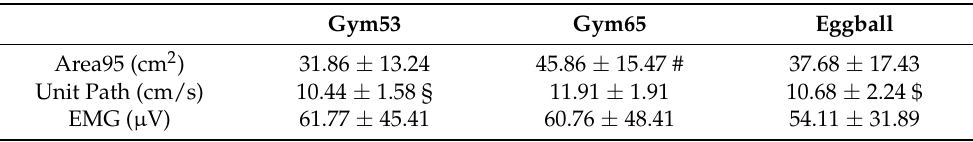
Table 1. One-way ANOVA results of the postural balance and EMG parameters for Gym53, Gym65, and Eggball during the EX condition. Data are presented as the mean ± standard deviation. # signifi- cantly different from Gym65 ( p < 0.001); $ significantly different from Gym65 ( p < 0.01); § significantly different from Gym65 ( p <